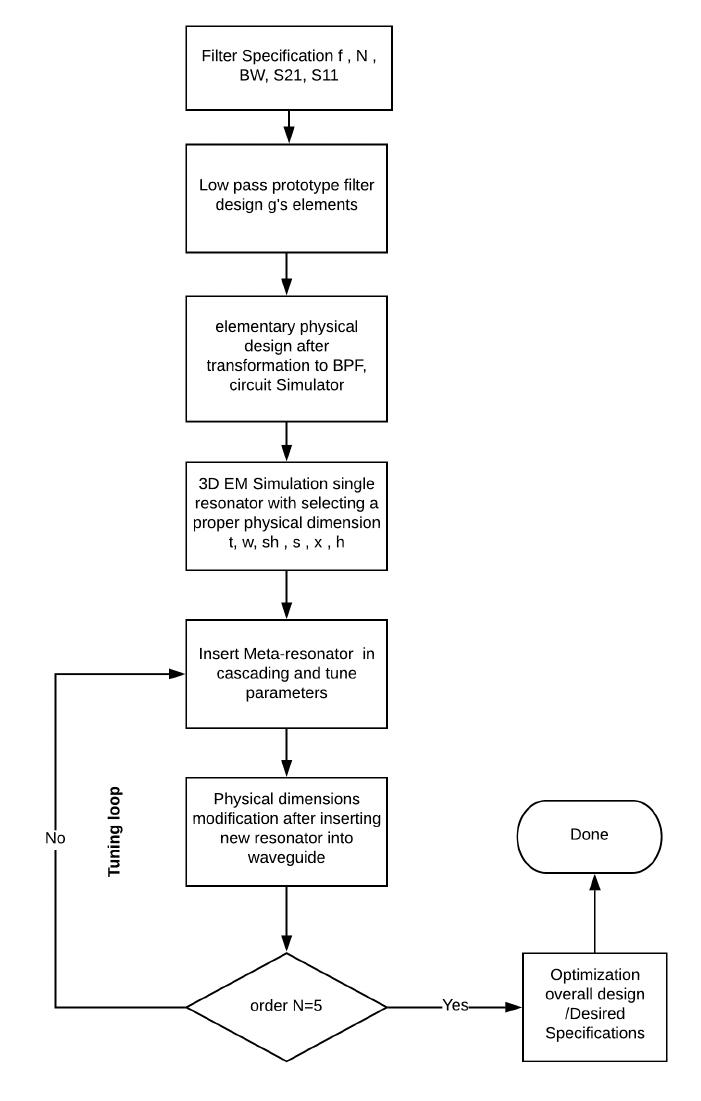
Figure 14. Flowchart of the waveguide filter design